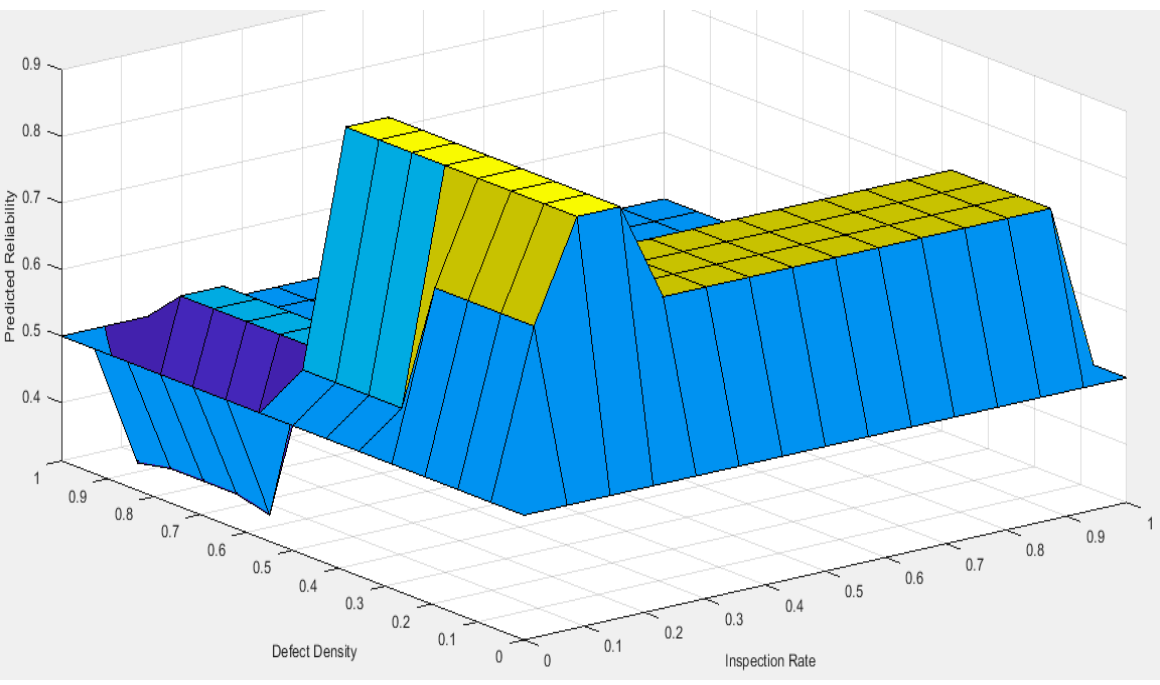
Figure 4. Surface view of experts’ based M-FIS.